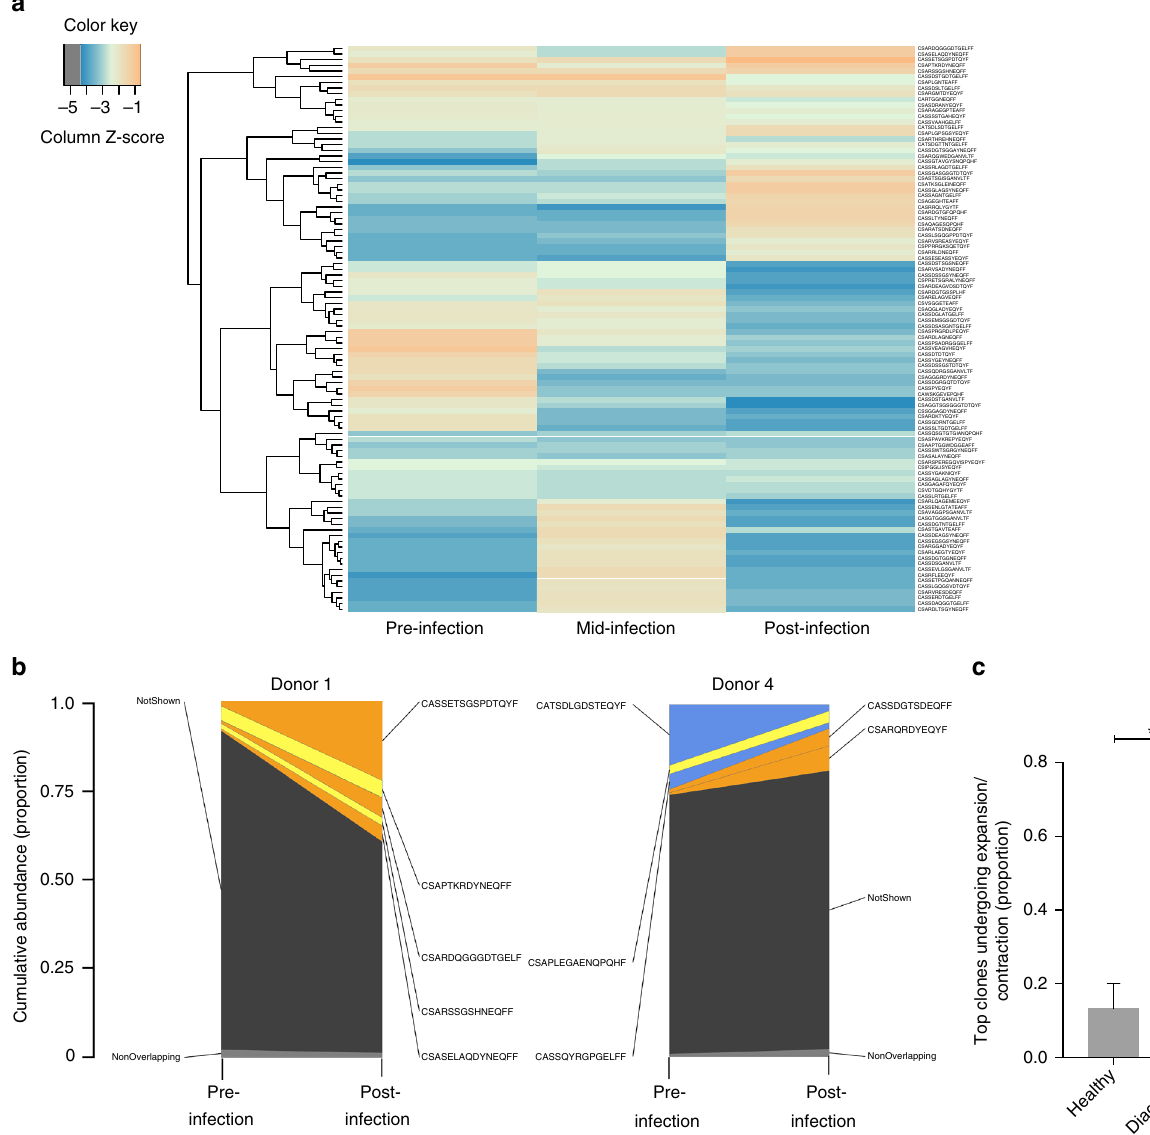
Fig. 4 MAIT clonotype composition is altered during enteric fever. MAIT cells were sorted from frozen PBMCs from individuals challenged with S . Paratyphi A and diagnosed with enteric fever (pre-, mid-, and post-infection) and the TCR β repertoire analyzed. a Representative clonotype tracking heatmap for a diagnosed individual (donor 1) showing top 100 clonotypes with hierarchical clustering on the left y -axis and the CDR3 β sequences on the right y -axis. b Example shared clonotype abundance plots for diagnosed donor 1 and donor 4. The top fi ve clonotypes shared pre- and post-infection are displayed. Orange indicates expanded clone ( ≥ 2-fold increase), blue indicates contracted clone ( ≥ 2-fold decrease) and yellow indicates a stable clone. c Graph summarizing the clonotype abundance plots, showing the proportion of the top fi ve clones undergoing either contraction/expansion over time in healthy controls ( n = 3) and diagnosed individuals ( n = 6). Bars plotted as mean with error bars representing SEM. Statistical signi fi cance calculated using Student ’ s unpaired two-tailed t -test where * P <